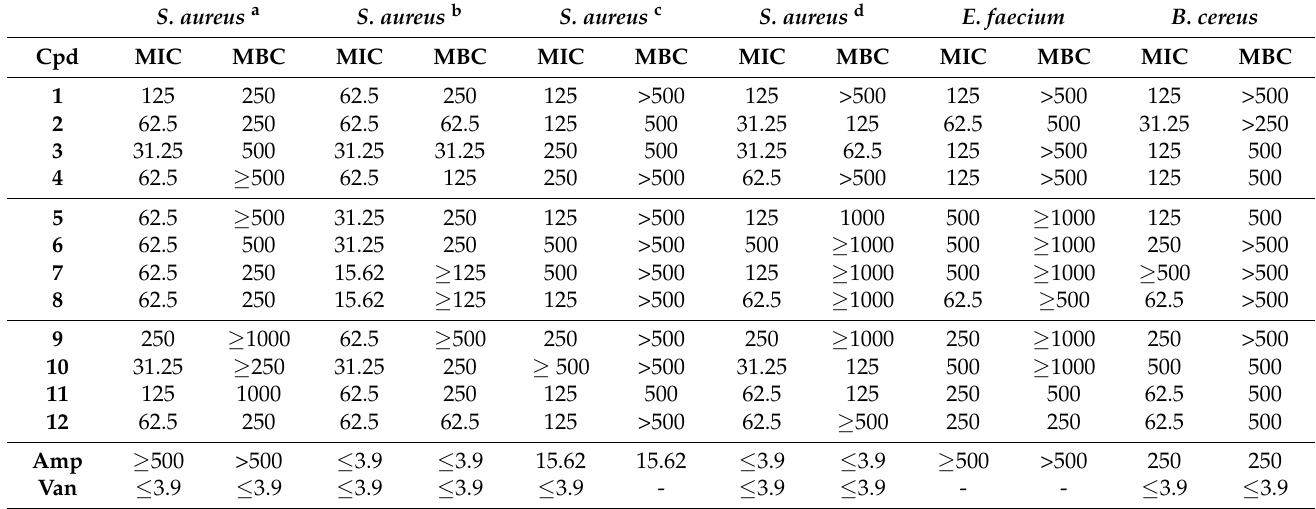
Table 2. MIC and MBC ( µ g/mL) of tested flavonoids against Gram-positive